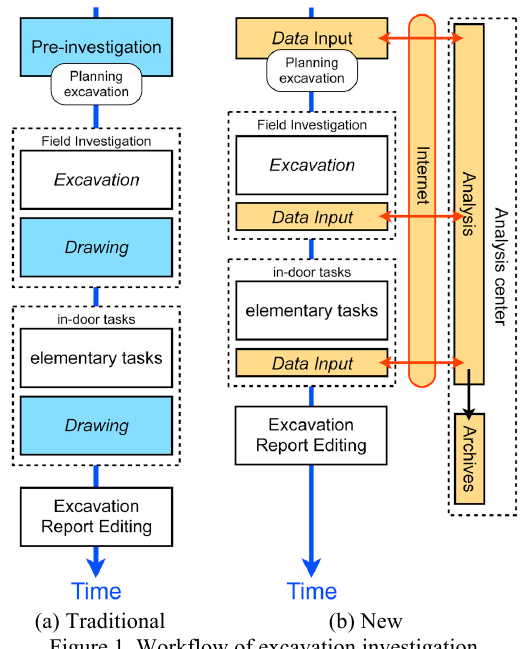
Figure 1. Workflow of excavation